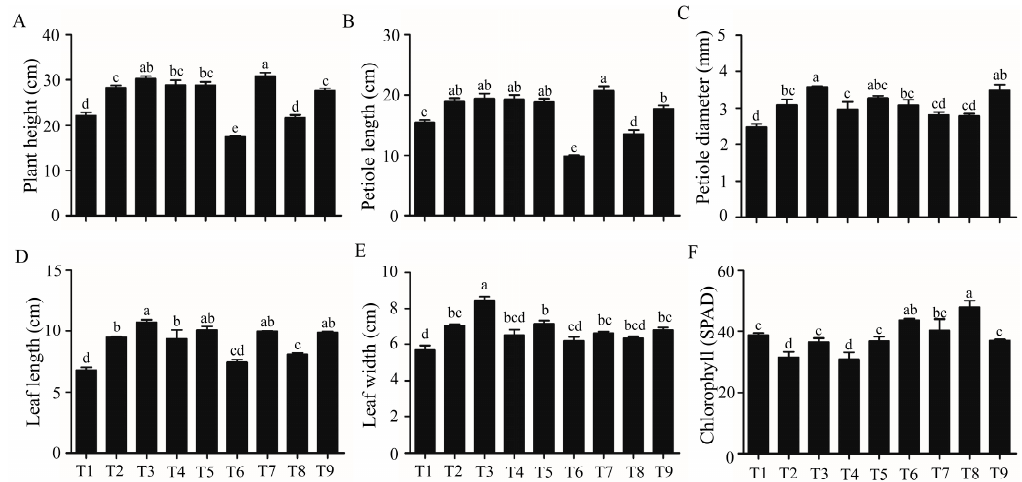
Figure 2. The growth parameters and chlorophyll content for each treatment. ( A ) Plant height; ( B ) petiole length; ( C ) petiole diameter; ( D ) leaf length; ( E ) leaf width; ( F ) chlorophyll. Data are presented as the mean ± standard error ( n = 3). Lowercase letters indicate the significant difference according to Duncan’s multiple range test at a 0.05 level.